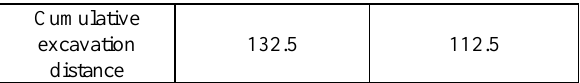
Table 1. Example of daily tunnelling length report